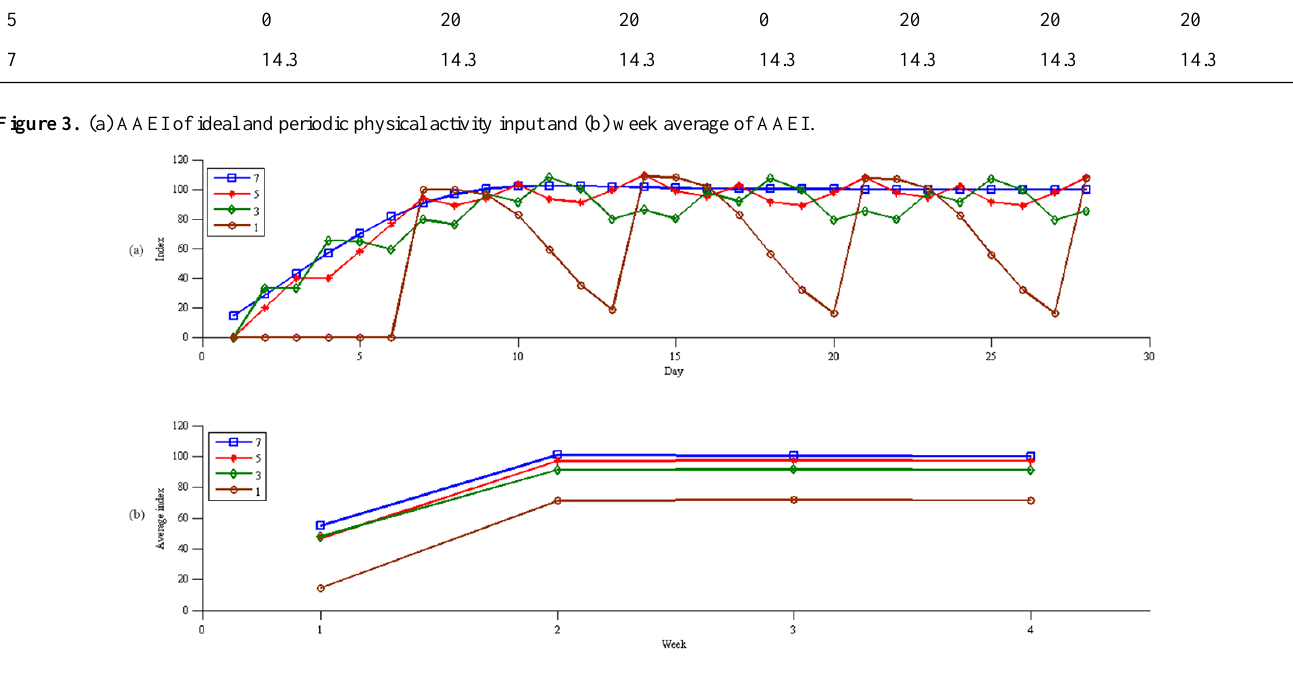
Figure 4. Average percentage of AAEI for different exercise days per week in an ideal